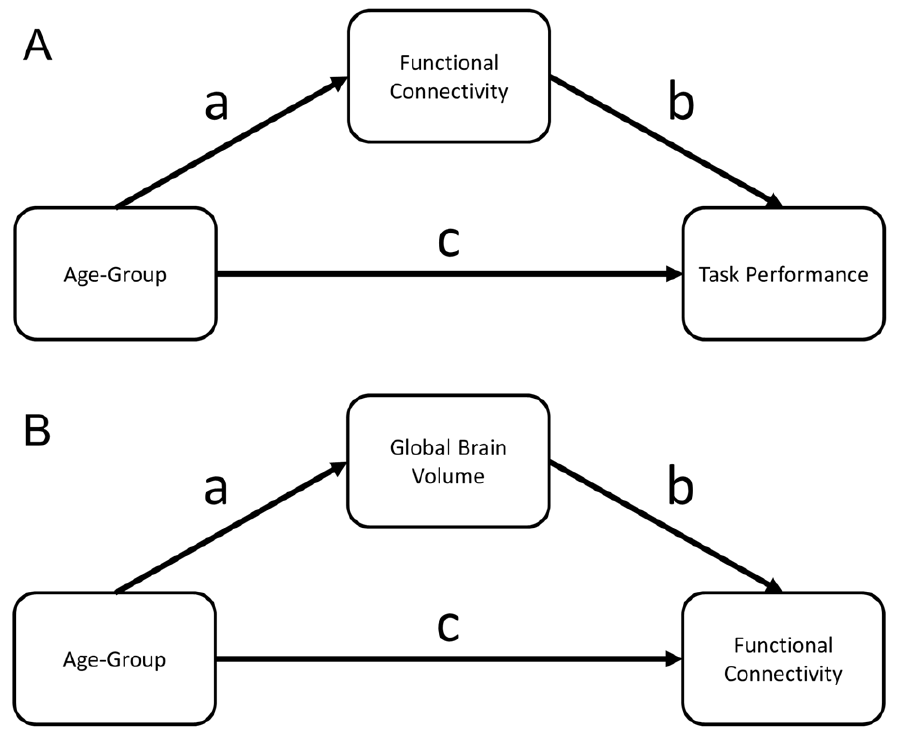
Figure 1. The mediation models. A) Model testing whether functional network connectivity is in the causal pathway between age-group and task performance. B) Model testing whether global brain volume is in the causal pathway between age-group and functional network connectivity.